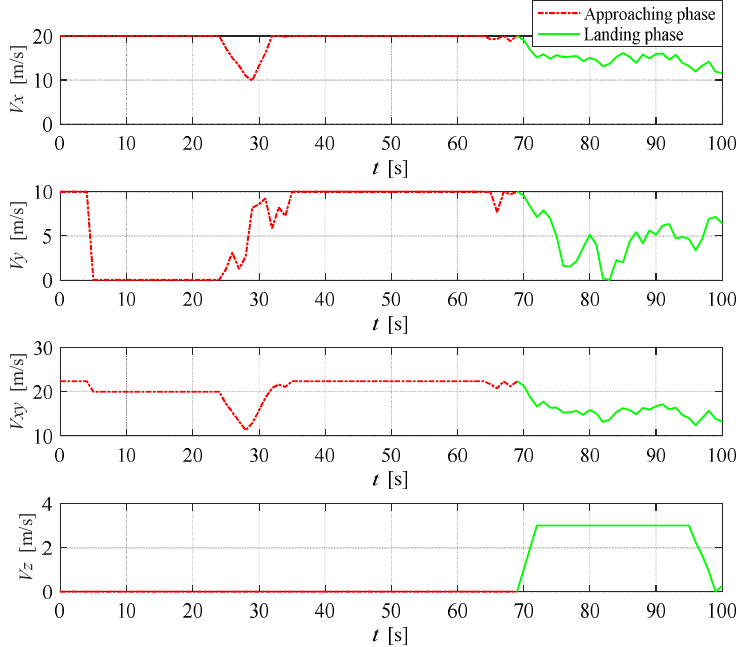
Figure 10. Velocity of the helicopter in the landing task considering the moving of the carrier. Table 4. Comparison between the actual state of the helicopter and the ideal state.